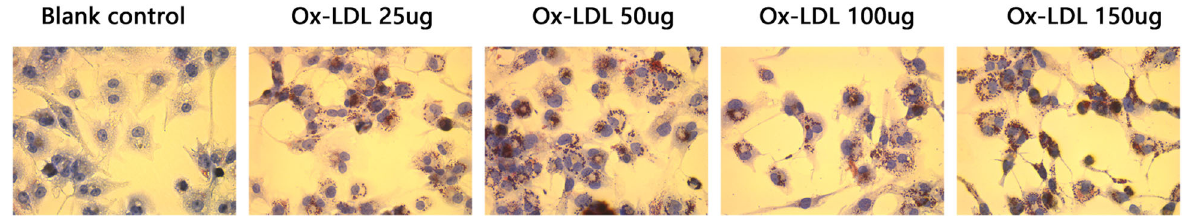
Fig. 2 Results of the positive staining of Oil Red O in foam cells treated with 25, 50, 100, 150 ug/ml Ox-LDL. Compared with blank control, the lipid drops in foam cells co-incubated with 25 ug/ml Ox-LDL were clear